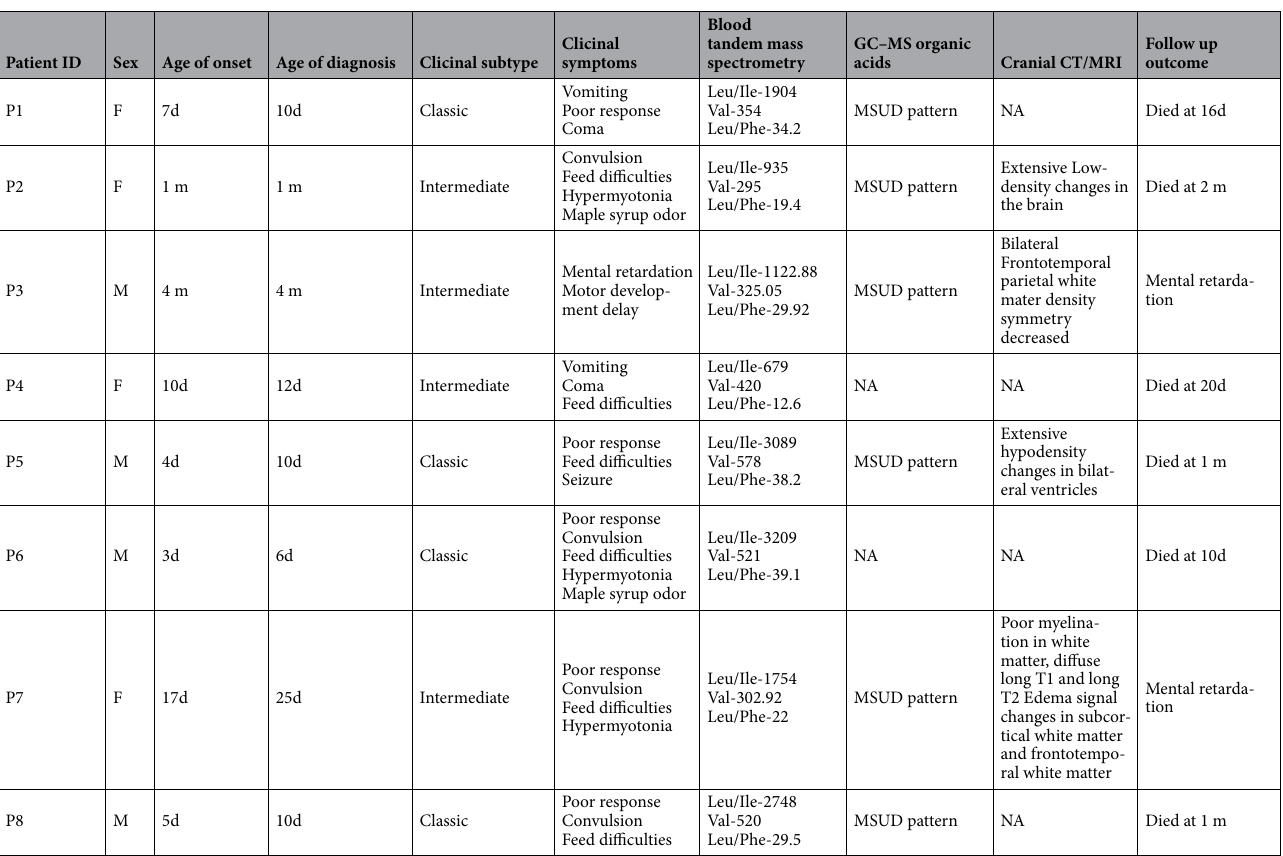
Table 1. Clinical and laboratory features of the 8 patients with MUSD. F Female, M Male, d day, m month, Leu Leucine, Ile Ileucine, Val Valine, Phe Phenylalanine, TMS acylcarnitine analysis using tandem mass